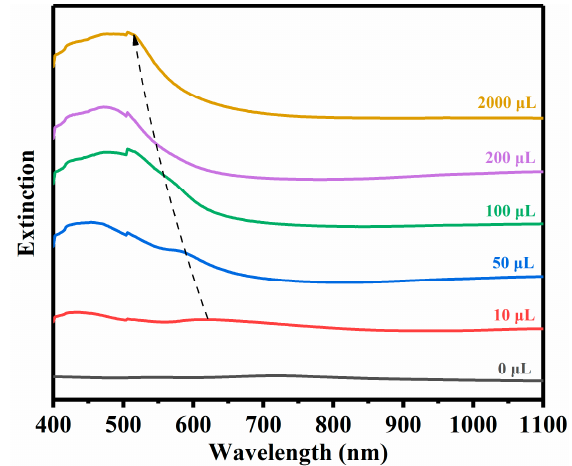
Figure 2. Extinction spectra of Ag@AuCu nanostructures (the Au:Cu atom ratio is 1.78) in aqueous solution. The numbers above the curves indicate the amounts of AgNO 3 .